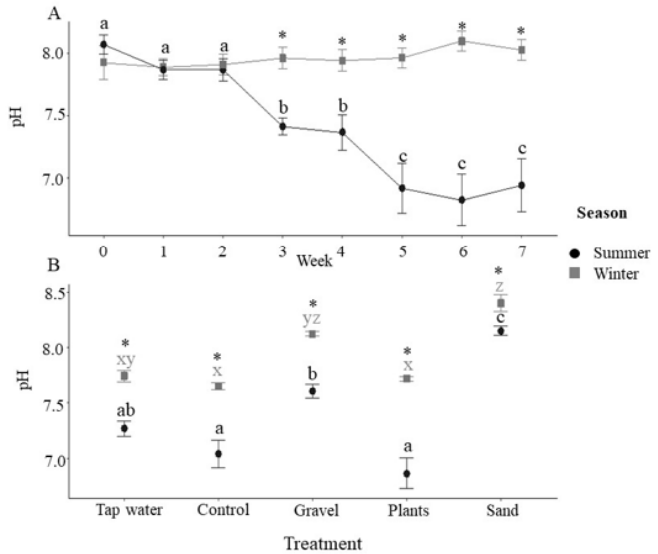
Figure 1. Tank pH. ( A ) Tank pH during summer and winter for each week of the 7-week experimental period ( n = 20 tanks at each time point combined across treatments). Asterisks indicate significance between season within a time point and different letters indicate significance between weeks within the same season (post-hoc Tukey p < 0.05). ( B ) Tank pH by enrichment method with incoming tap water values also presented (tap water: n = 7; for control, gravel, plants, sand, n = 35 i.e., 5 tanks × 7 weeks with data combined across time). Asterisks indicate a significance between seasons within a treatment and different letters indicate significance between treatments within the same season (post-hoc Tukey p < 0.05). All data are means ± SEM. Incoming water was consistently held at 25 °C and despite the heaters present in each tank, a small but significant elevation in temperature was observed during the summer, which did not vary with enrichment treatment (Supplementary Figure S1). Dissolved ox- ygen was variable throughout the experiment, but with no discernible patterns generated by season or enrichment treatments (Supplementary Figure S2). Total ammonia nitrogen (TAN) remained below the detection levels in the winter (Figure 2) and in summer, it varied with time (Figure 2A), with significantly higher concentrations in the bare tanks and plant enriched tanks than in the incoming water, gravel and sand enrichment treat- ments (Figure 2B). When adjusted for pH and temperature, unionised ammonia remained significantly lower in the winter (Figure 3A), but the effect of enrichment treatment ob- served with TAN was lost, with no significant effect of enrichment (Figure 3B).